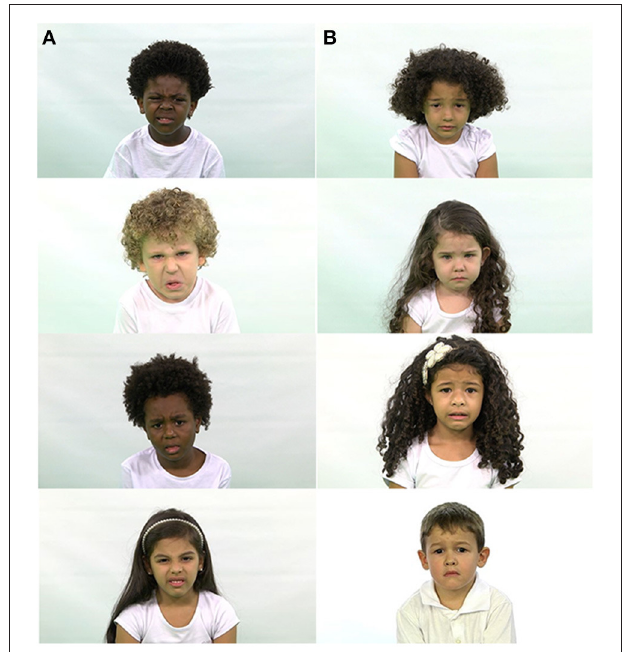
FIGURE 2 | Examples of ChildEFES database images. (A) Disgust (B) Sadness.